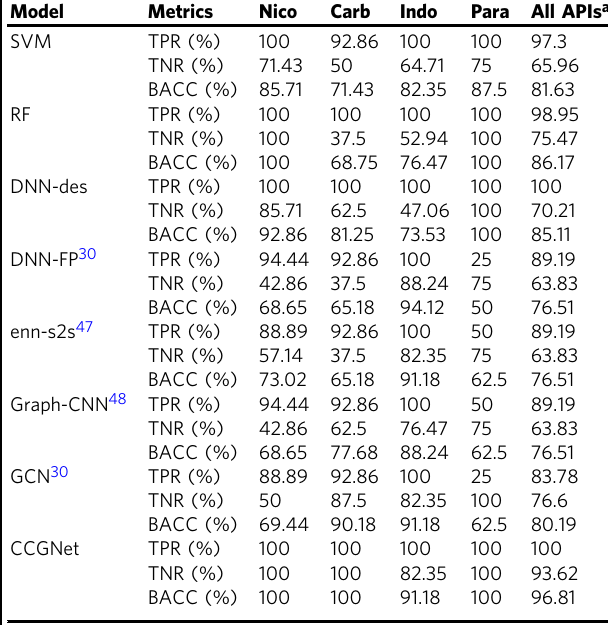
Table 4 Prediction performances of all the models on the co- crystals involving Nicotinamide (Nico), Carbamazepine (Carb), Indomethacin (Indo), and Paracetamol